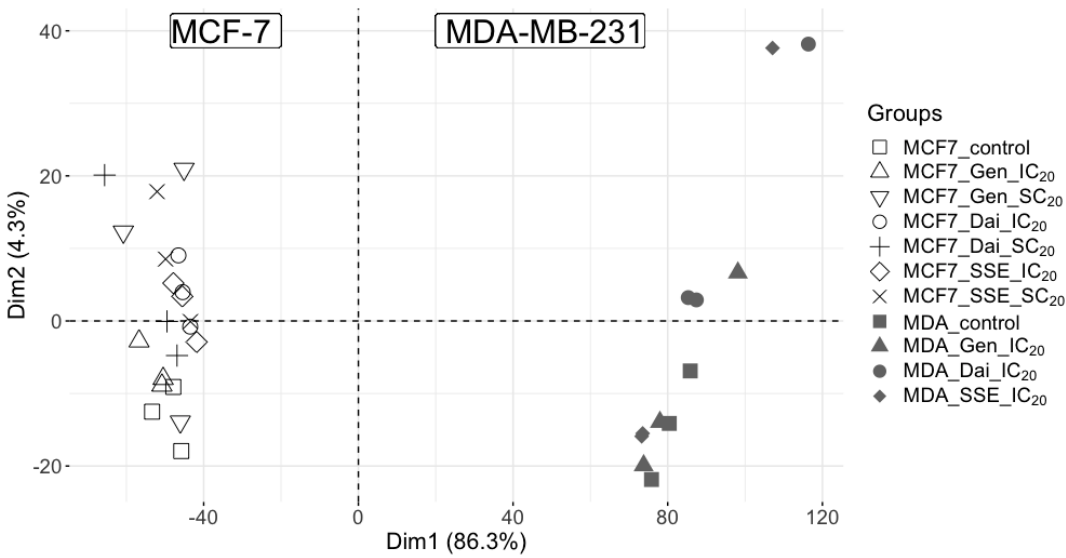
Figure 2. Principal component analysis displaying the sources of variance among all samples. The major variance (86.3%) is attributed to the cell type.